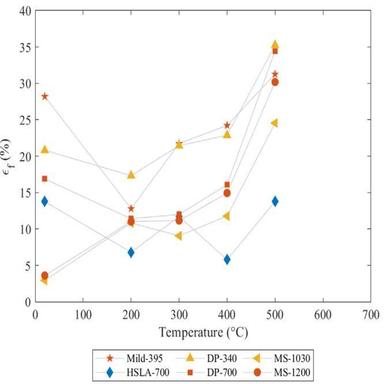
Elongation at fracture εf obtained from steady-state tests. Note 40% is the maximum measurable strain in the test setup, which was exceeded at 600 °C and 700 °C.